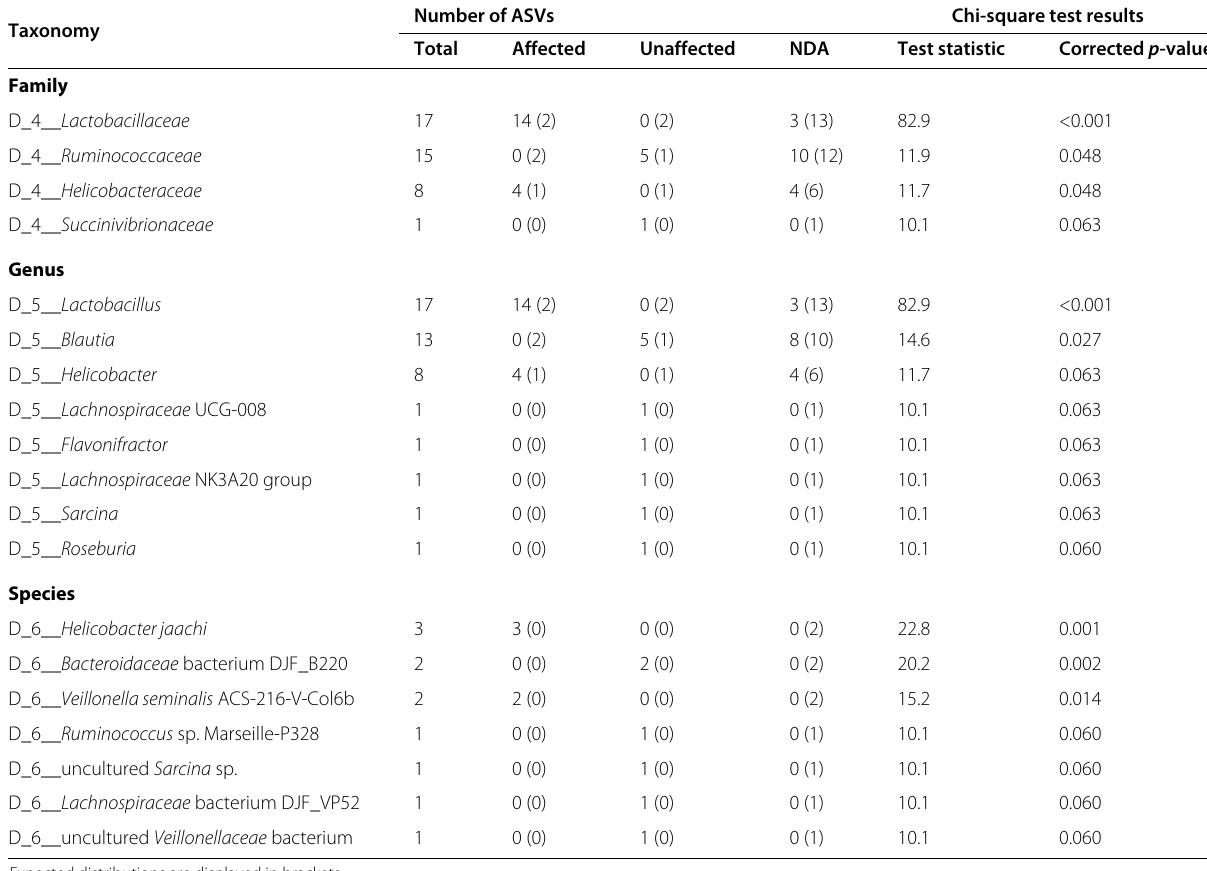
Table 1 Taxonomic divisions containing ASVs identified as differentially abundant between affected and unaffected tamarins and were that significantly different to an expected distribution Number of ASVs Chi-square test Taxonomy